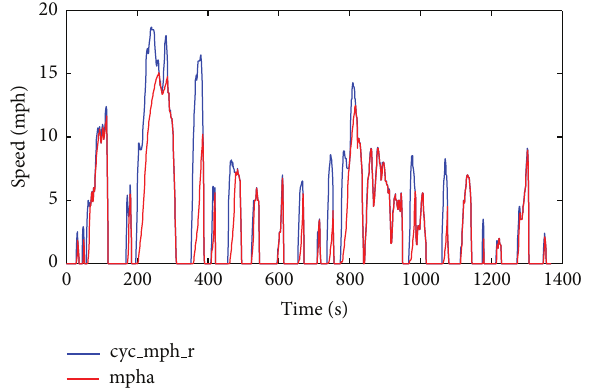
Figure 10: The speed of simulation and drive cycle.